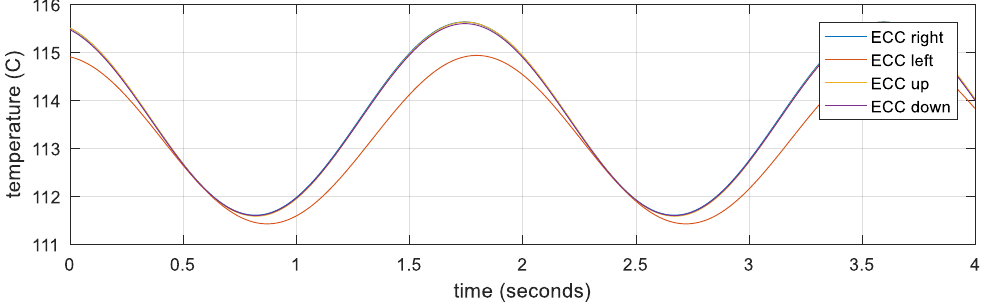
Figure 10. Sensor temperature for 1 mm crack in one magnet at a time.